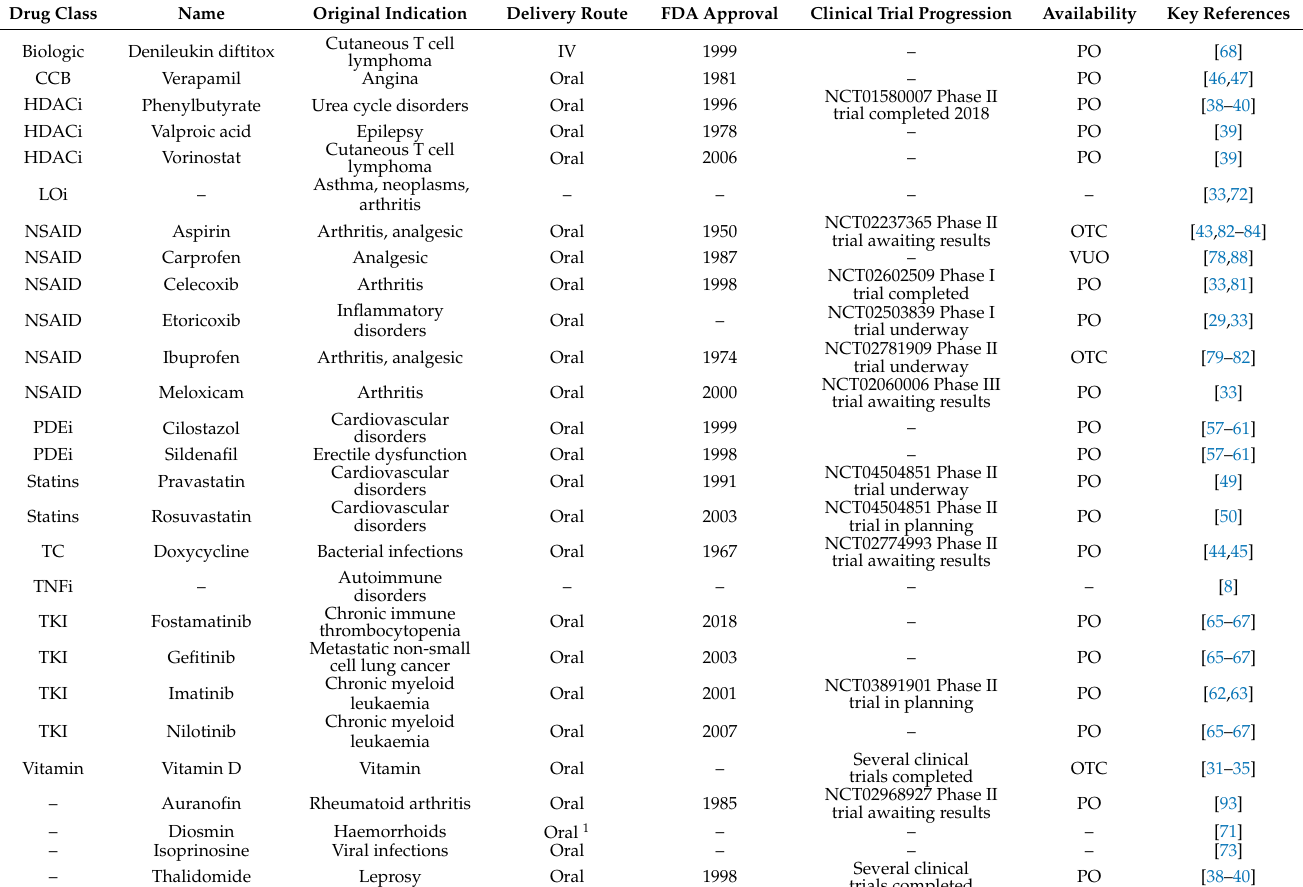
Table 1. Summary table of the most promising immunomodulatory drugs discussed in this literature review currently under investigation for their potential to be repurposed as an adjunct drug for the standard anti-TB drug